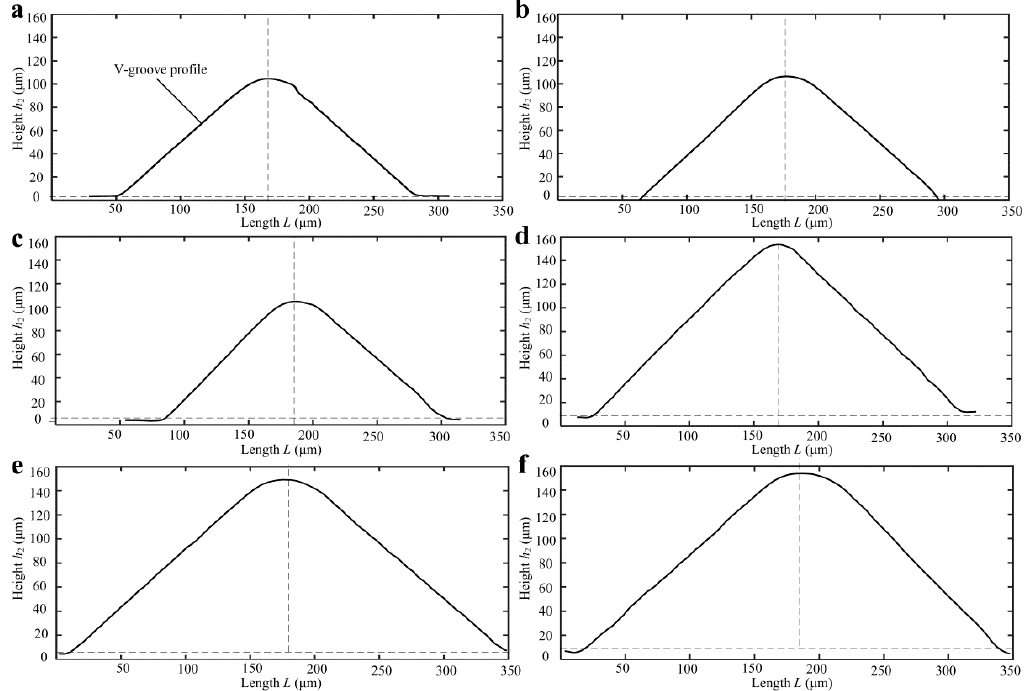
Figure 7. Table 5. The V-grooved structure parameters of micro-structured polymers.